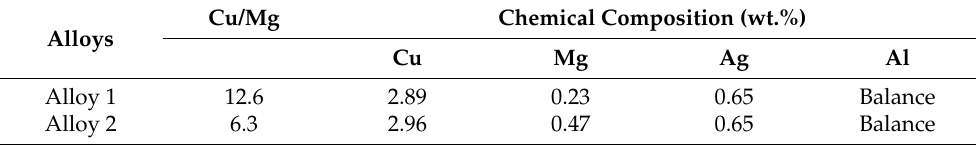
Table 1. The chemical composition of the experimental alloys. Cu/Mg Chemical Composition (wt.%) Alloys Cu Mg